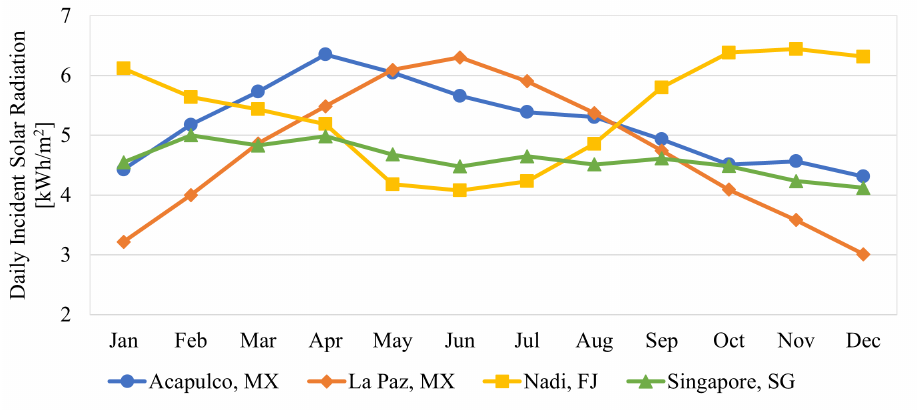
Figure 9. Average daily solar radiation received.